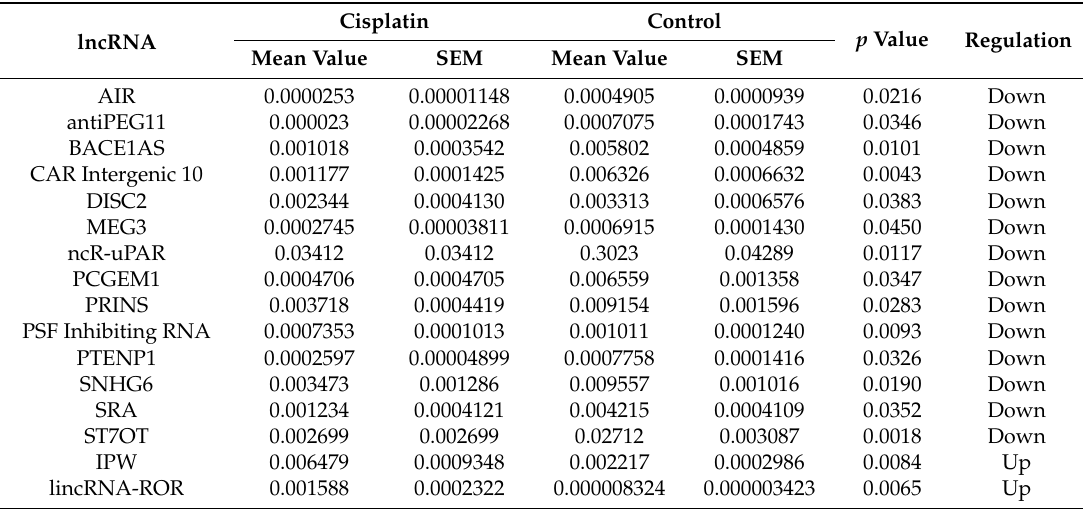
Table 5. Expression values of changed lncRNAs after exposure to cisplatin.